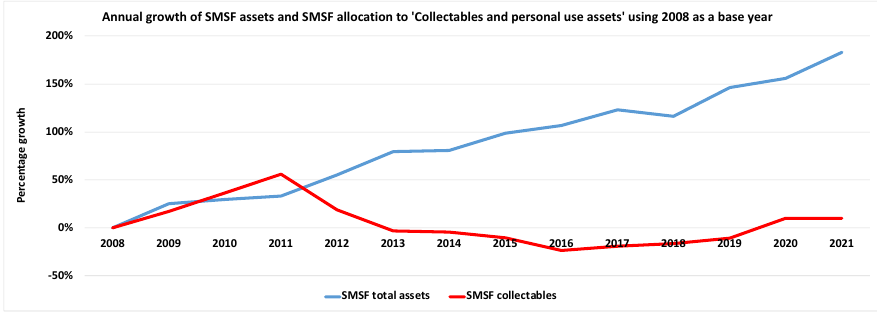
Figure 4. Annual growth of SMSF assets and SMSF allocation to ‘Collectables and personal use assets’. Source: Author, using data from the Australian Taxation Of-